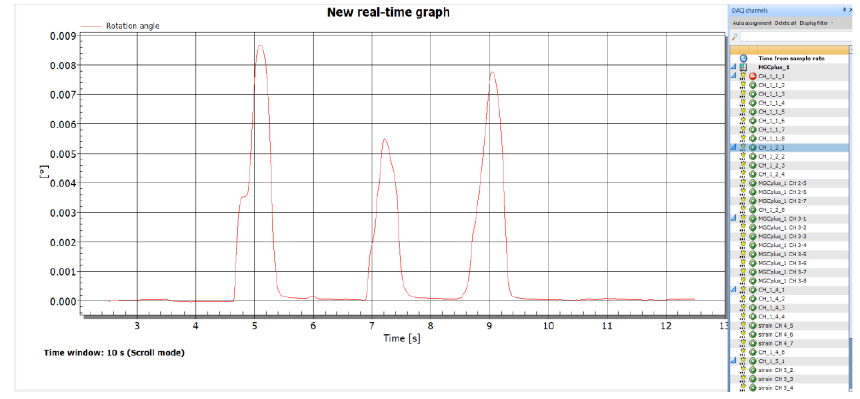
Figure 5. Data acquisition module